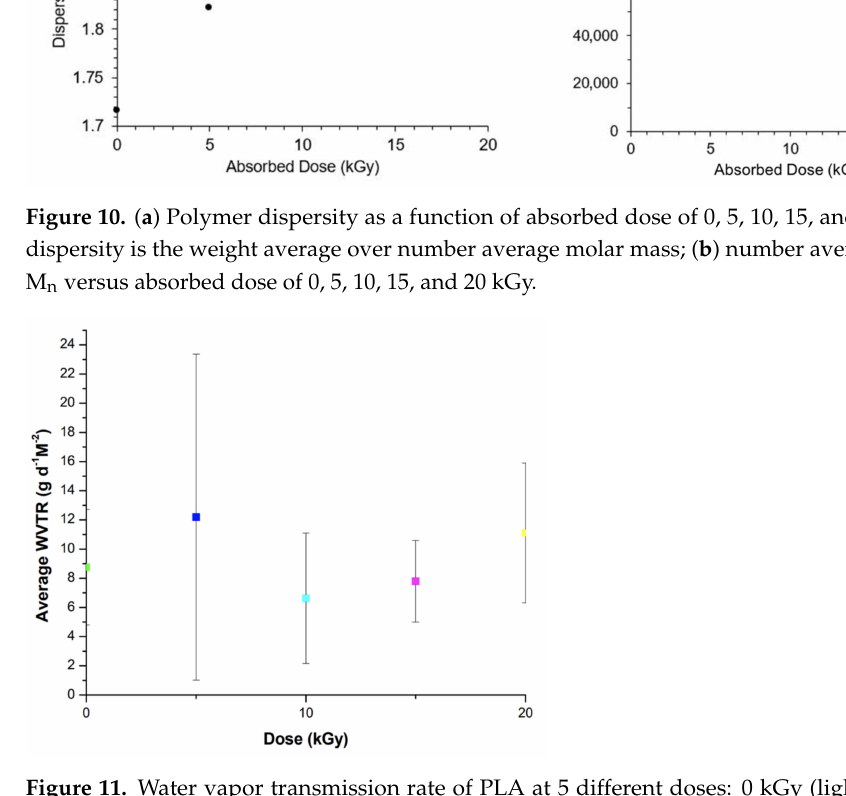
Figure 11. Water vapor transmission rate of PLA at 5 different doses: 0 kGy (light green), 5 kGy (dark blue), 10 kGy (light blue), 15 kGy (pink), 20 kGy (yellow). Each point represents the average of samples measured at each